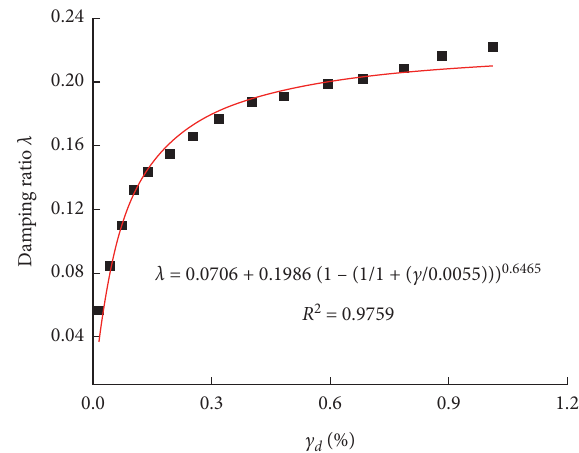
Figure 10: Typical dynamic shear modulus-shear strain curve fitting